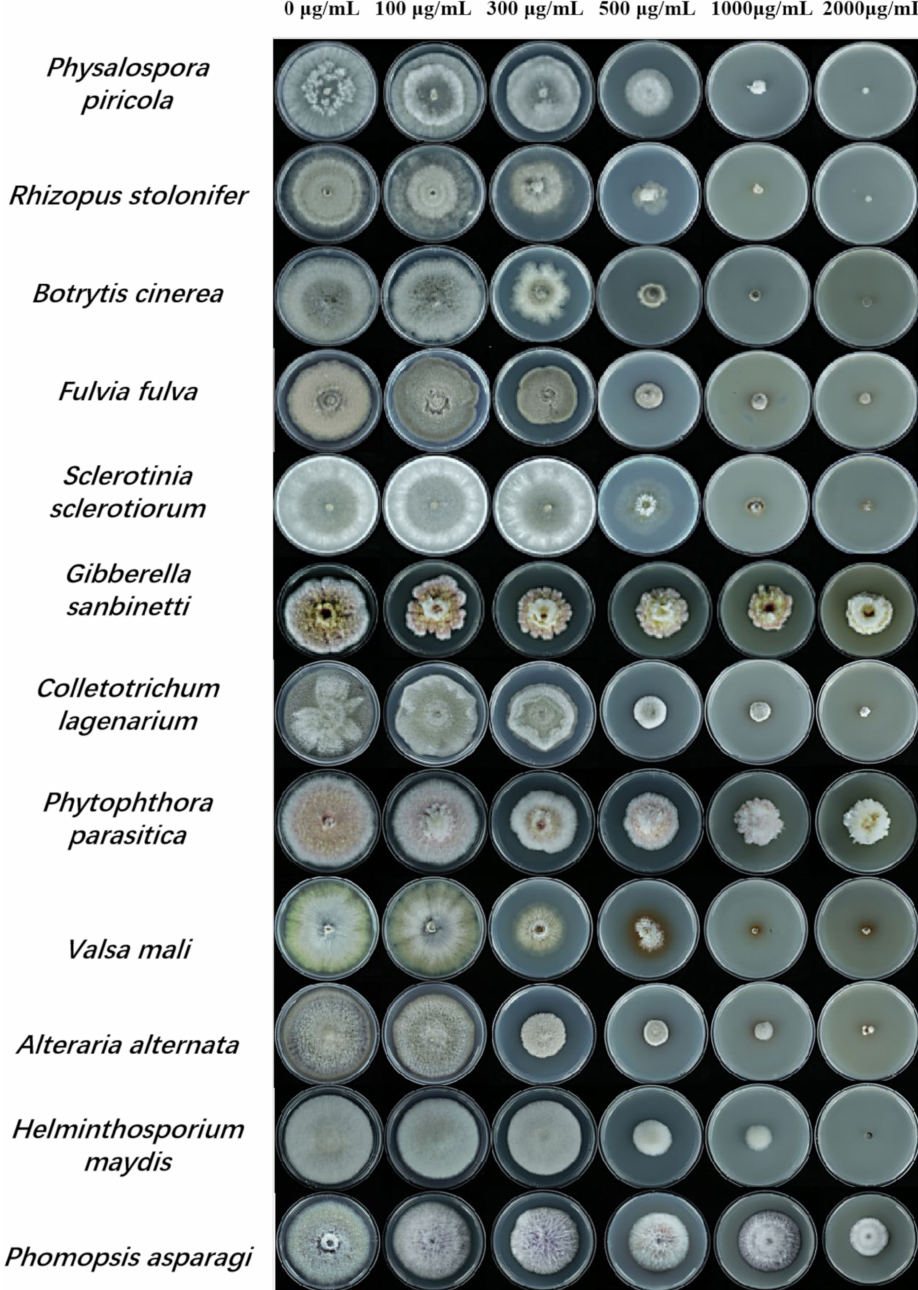
Figure 1. Antifungal spectrum of ε poly L lysine ( ε -PL) treatment for different plant pathogenic fungi. When the fungus had grown to completely fill the plate in the control for each species (distilled water-treated), the colony diameters on the experimental plates were